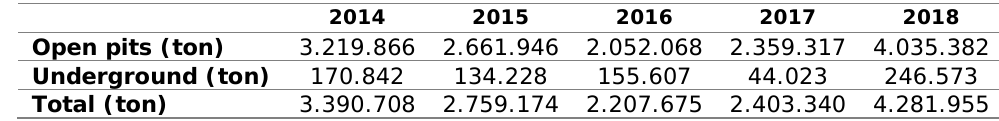
Table 1. Salable Lignite Production of WLC for the Years 2014 and